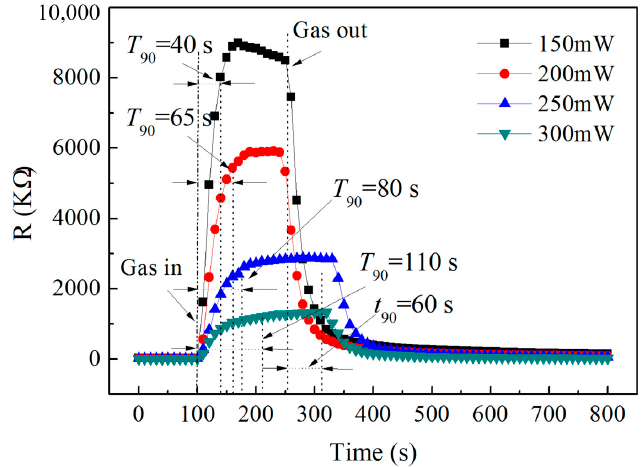
Figure 10. Gas sensing response and recovery property curves of the micro hotplate sensor detecting high concentration NO 2 at different power consumptions of ( a ) 150; ( b ) 200; ( c ) 250; and ( d ) 300 mW in the range of 5 to 100 ppm.